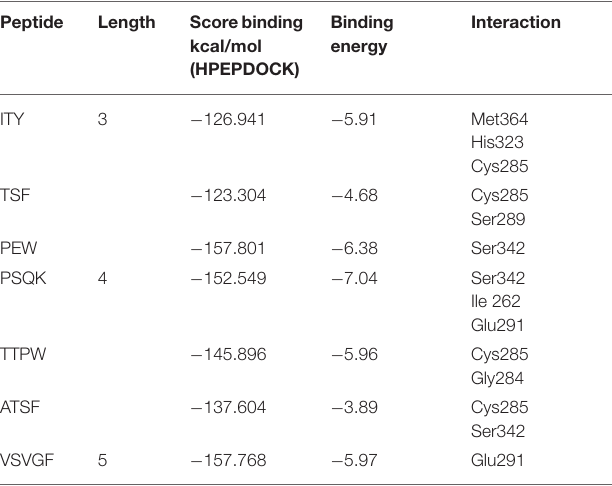
TABLE 9 | Binding energies and bonds of peptides with binding point < − 120 kcal/mol in antiadipogenic sites of PPAR γ .